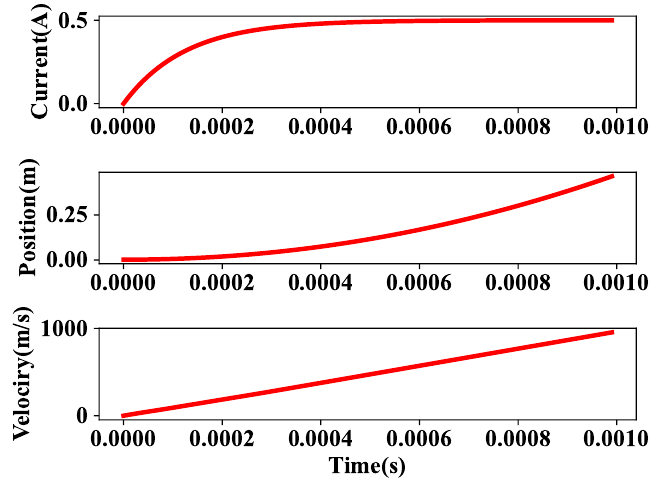
Figure 3. Current, motion, and velocity